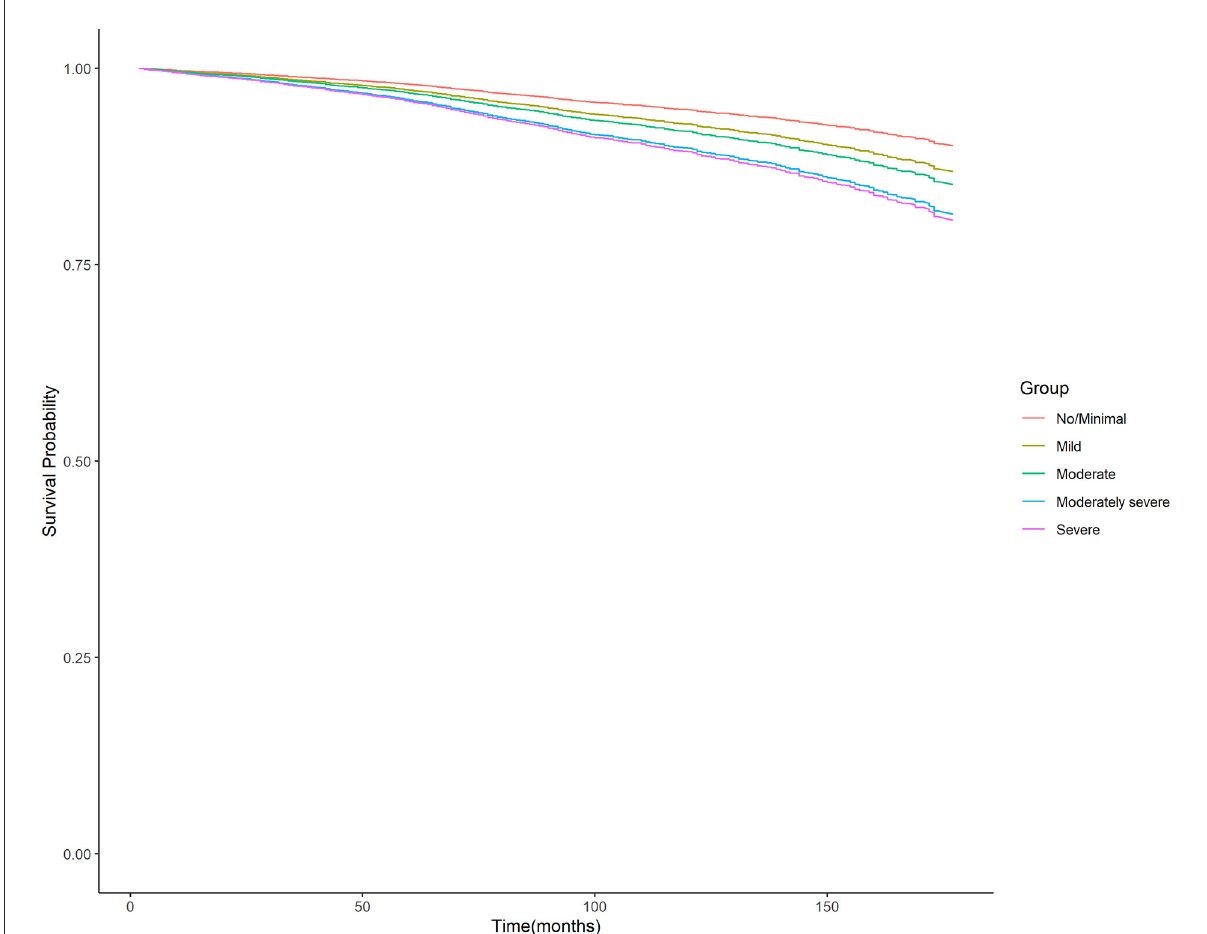
FIGURE3 Unadjusted survival curves of weighted cox proportional hazard model for all-cause mortality. PHQ-9, nine-item Patient Health